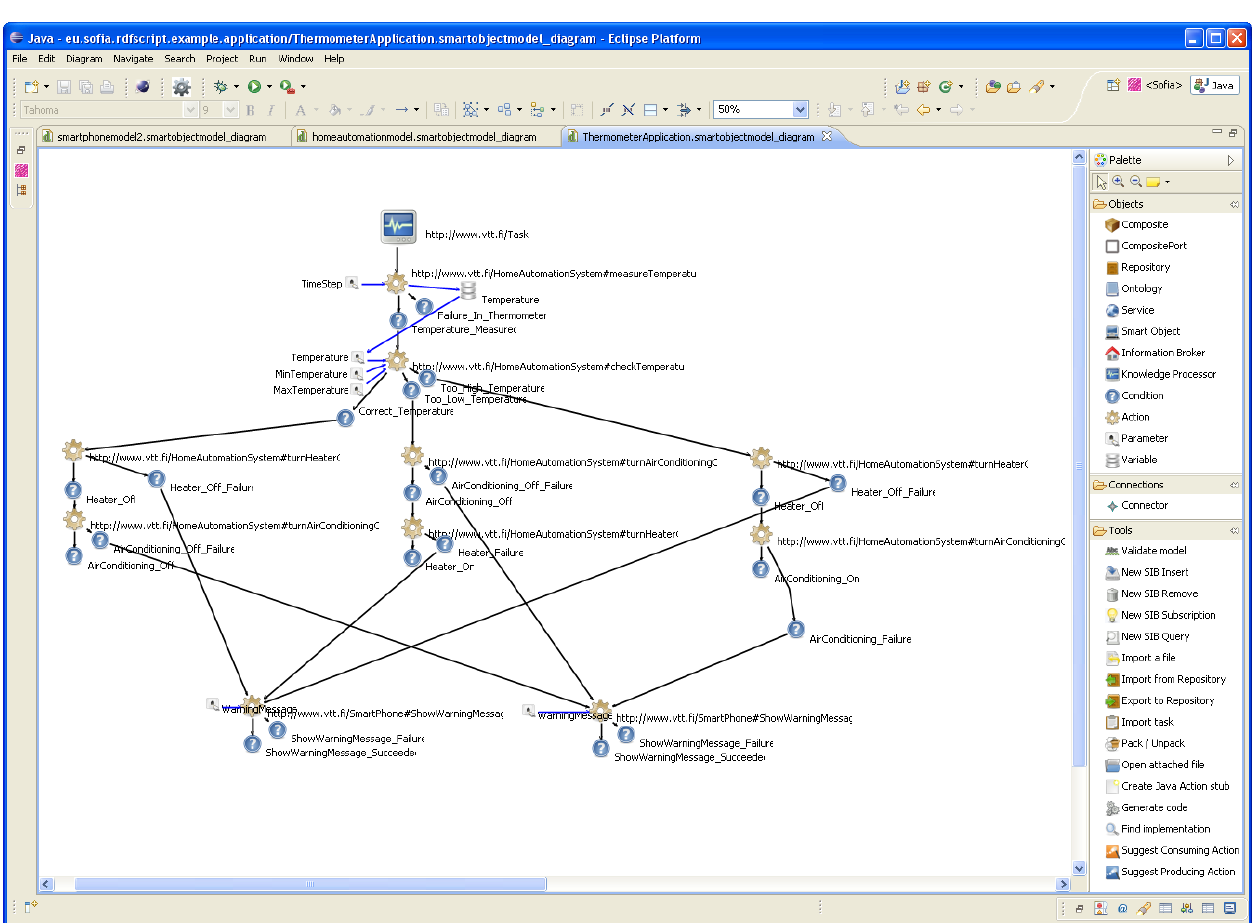
Figure 1. The main window of the Smart